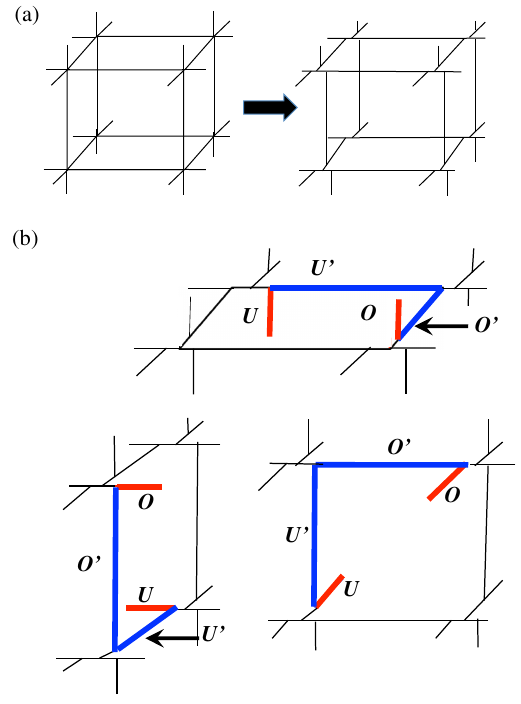
FIG. 6. (a) We define our model on the point-split cubic lattice, because the Hamiltonian is simplest for a lattice with only trivalent vertices. (b) The plaquette term is defined with respect to a fixed angle of projection. In this angle, there are two edges ( O and U ) that are projected into each plaquette from above and below, respectively, shown in red. These (and their partner edges O 0 and U 0 , shown here in blue) are used to define the phase ; Φ factors Φ in the O;O 0 U;U 0